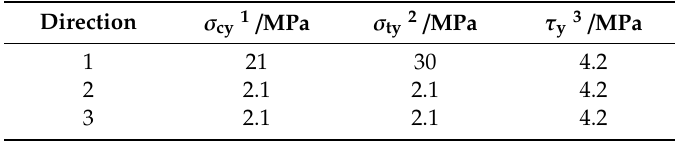
Table 2. Plastic material parameters of the FE